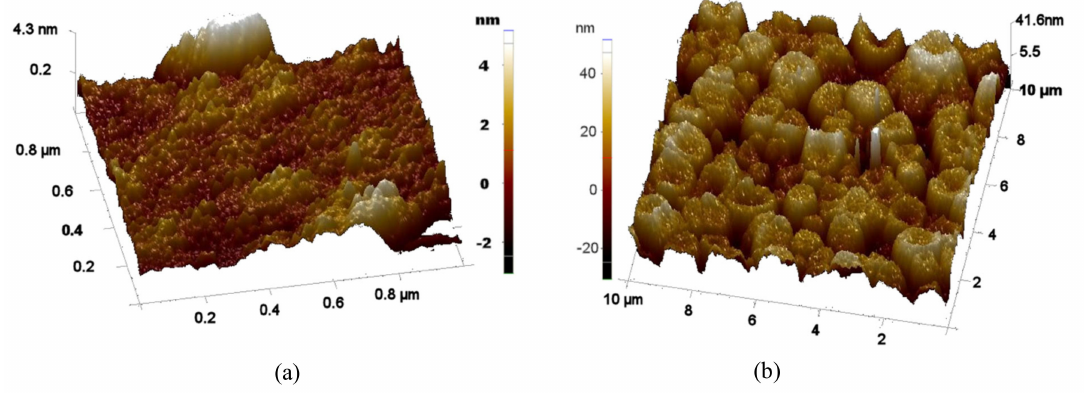
Figure 2. 3D atomic force microscope (AFM) images of an as-deposited PCT film on Si substrate at 550 ◦ C ( a ) without annealing and ( b ) after annealing at 600 ◦ C for 15